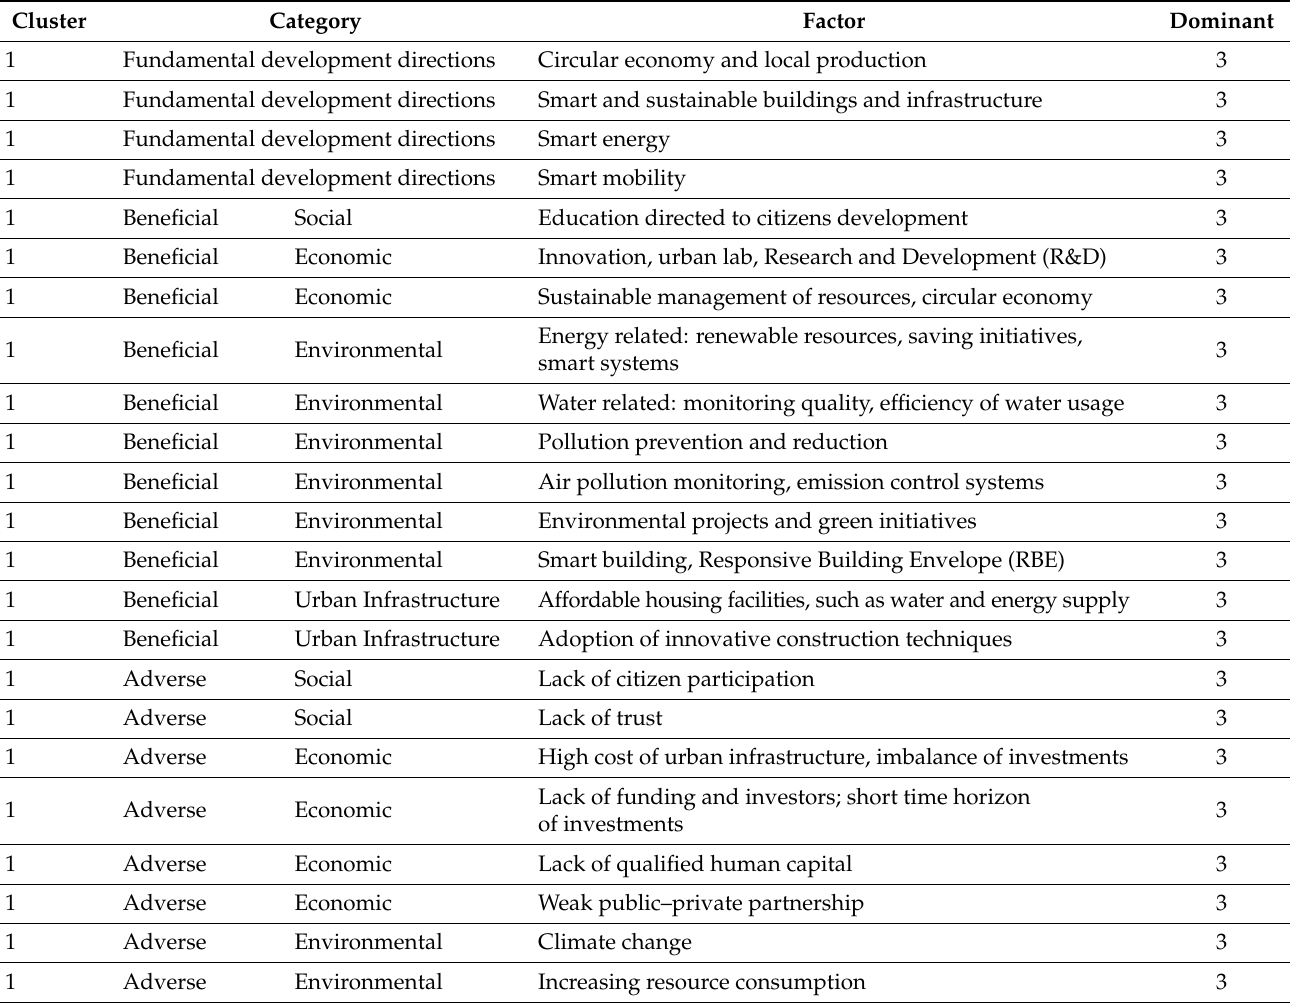
Table 11. Fundamental development directions, beneficial factors, and adverse factors of smart city in the opinion of experts until 2030 in Poland—the highest-dominant response cluster (own